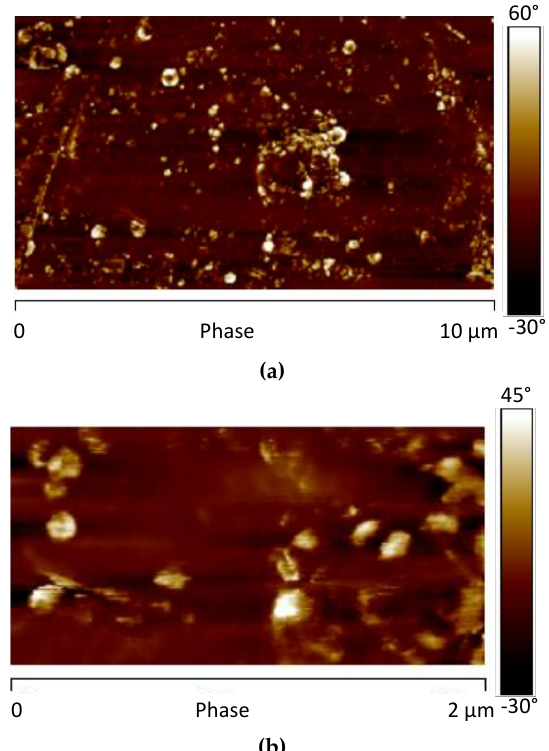
Figure 13. AFM phase map image of the sample 0GNPs (550) acquired adopting a scan size of 10 µm ( a ) and 2.0 µm ( b ).